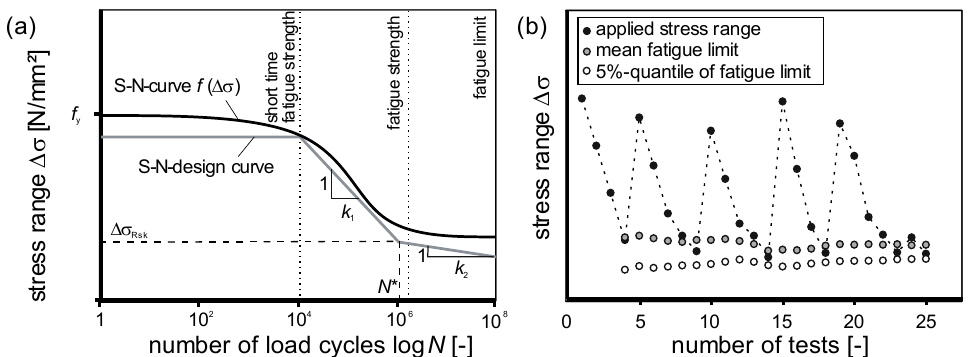
Figure 5. S–N curve ( a ) and process description of test procedure ( b ) according to the interactive method [57].